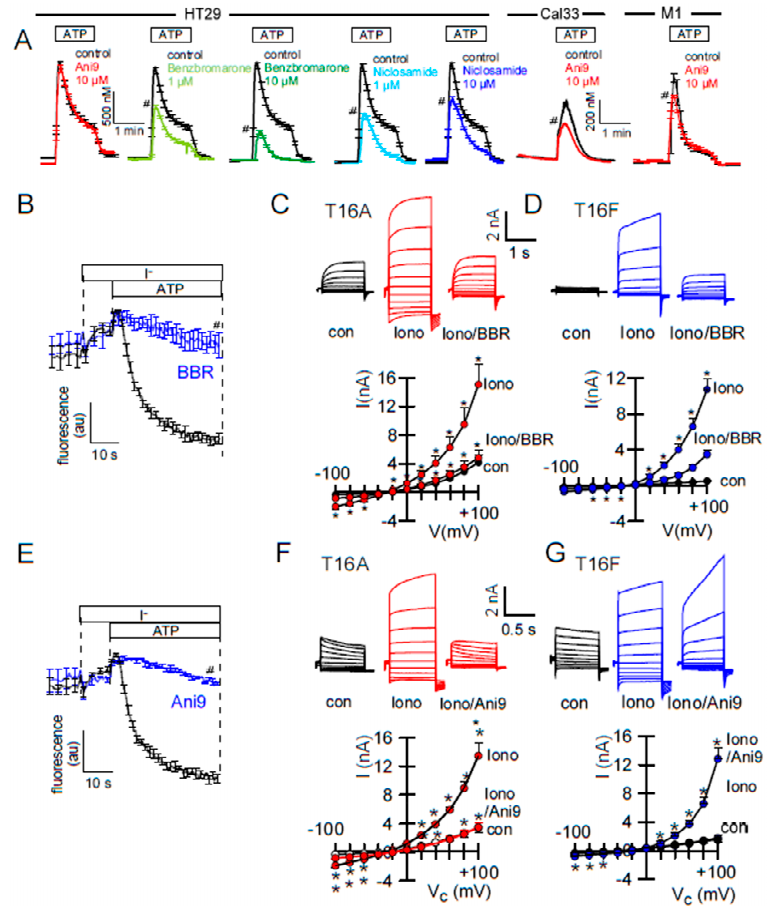
Figure 3. E ff ect of inhibitors on Ca 2 + -activated Cl − transport and ATP-induced rise in [Ca 2 + ] i Figure 3. Effect of inhibitors on Ca 2+ -activated Cl − transport and ATP-induced rise in [Ca 2+ ] i . A )